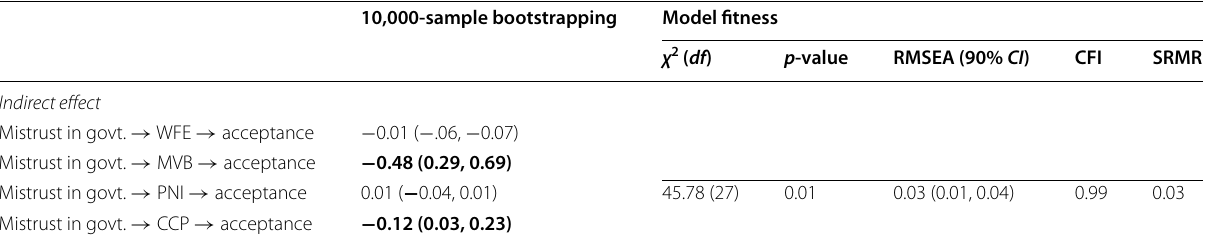
Table 4 Unstandardized indirect effects and model fitness